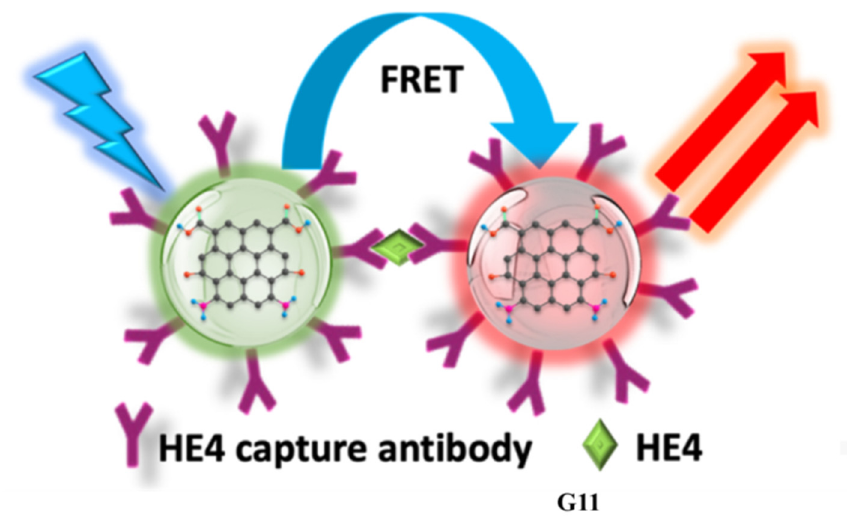
Figure 13. Schematic diagrams of the FRET sensing mechanism between gGQDs and rGQDs ( G11 ) with the HE4 antibody. Reprinted from [68] with permission from Elsevier.